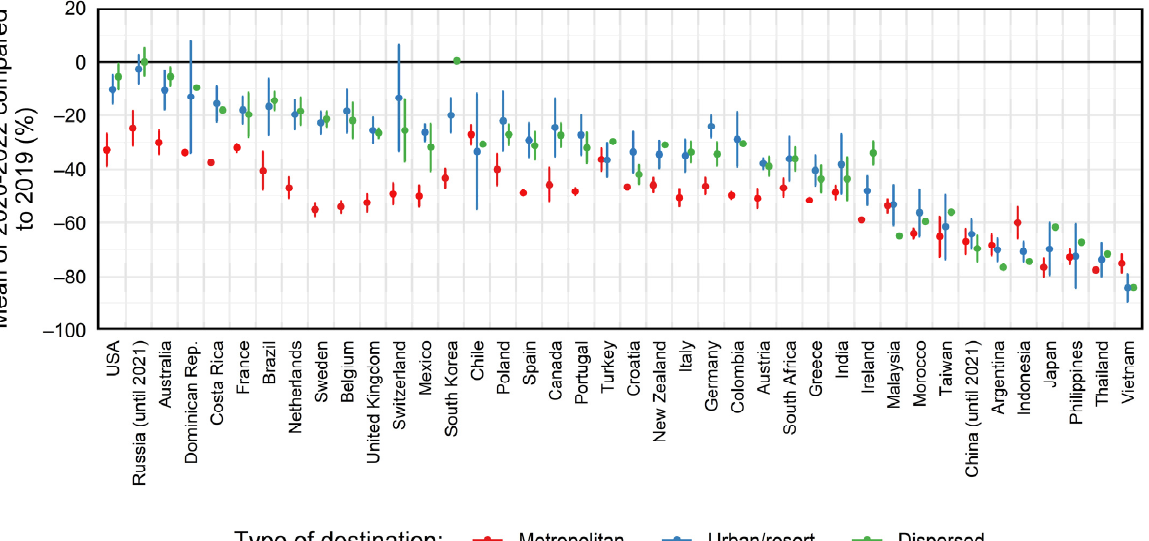
Figure 4. Change in the number of reviews in destinations by country (countries with at least ten destinations are presented, dots indicate median values, bars indicate interquartile ranges).